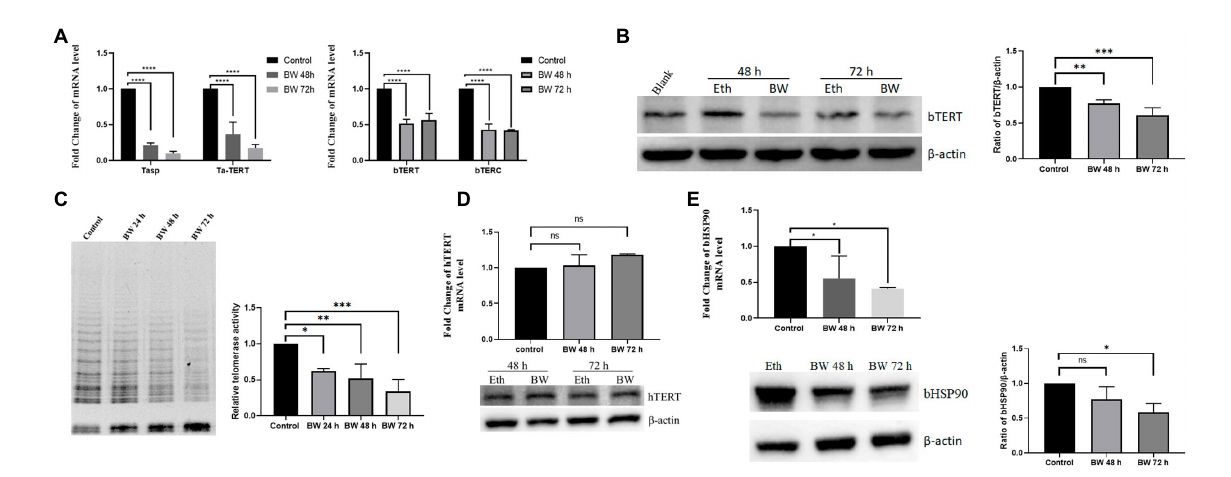
FIGURE 3 Effect of buparvaquone (BW) on the telomerase activity of host cells: (A) Changes in the transcription levels of T. annulata genes (Tasp., Ta-TERT) and host cell genes (bTERT, bTERC) after treatment with 200 ng/ml BW. (B) Western blot analysis of bTERT expression after cells treated with BW (left). The blank group is the normal cells. Eth means the cells incubated with a same amount of ethanol as in BW group. Quantification of Western blot for bTERT protein levels using ImageJ software (right). (C) Telomerase activity detection by TRAP assay. The control group consisted of cells cultured with ethanol (left). Quantification of relative telomerase activity by using ImageJ software (right). (D) HeLa cells were treated with 200 ng/ml of BW for 48 and 72 h and then, the hTERT transcription and expression levels were analyzed by Q-PCR and Western blot, respectively. (E) The expression level of bHSP90 was decreased after parasites were eliminated by BW from TaNM1 cells. Quantification of Western blot for bHSP90 protein levels using ImageJ software. The one-way ANOVA was used for statistical analysis ( n = 3 times independent experiments). ns means no significant difference, * p < 0.05,